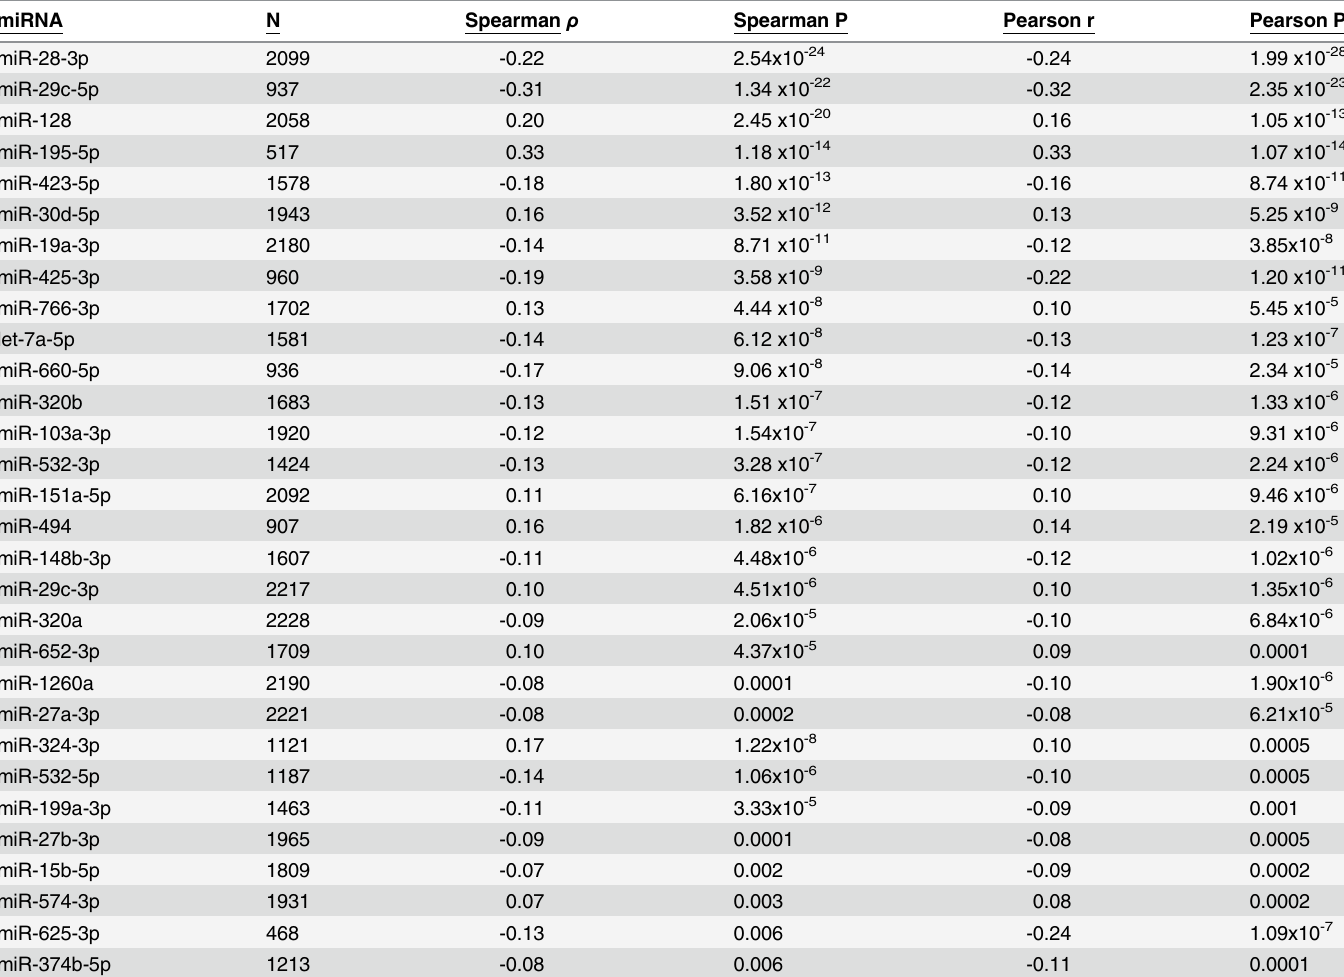
Table 1. Correlation coefficients (Pearson and Spearman) of whole blood vs. plasma miRNAs. N refers to the number of FHS participants on which each correlation is based. A P-value threshold (Bonferroni-adjusted) is specified in text.